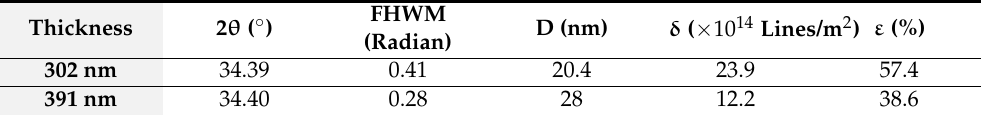
Table 2. Structural parameters of the grown ZnO thin films onto the p-GaAs substrates.